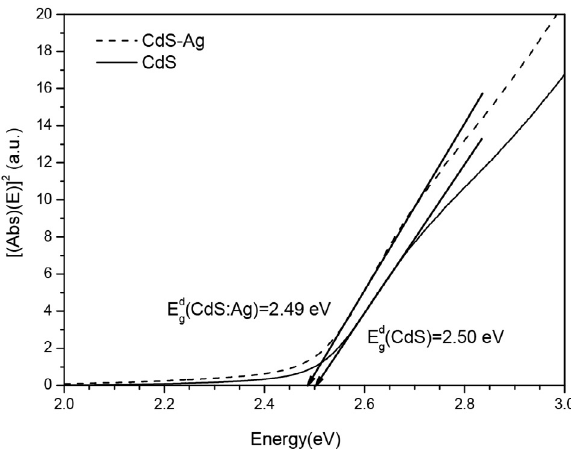
Figure 2. Direct band gaps obtained via the Tauc